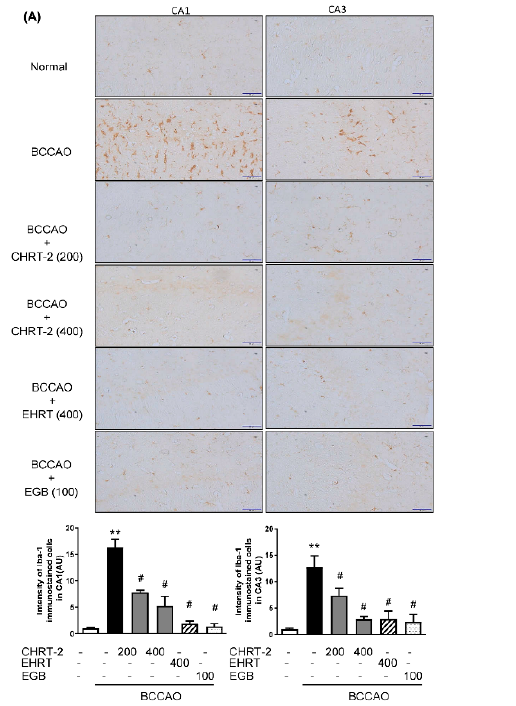
Figure 5. Effect of HRT on inflammatory responses in the BCCAO-induced VaD rats. ( A ) Immunohistological analysis was carried out to examine the expression of ionized calcium binding adaptor molecule 1 (Iba-1), a microglial marker, in the hippocampus of BCCAO rats. Representative photomicrographs are shown at magnifications of 400 × . The immunohistochemical signal intensity was calculated in a brain tissue section from each rat using Image J software. The staining intensity results are reported in arbitrary units (AU). ( B ) Hippocampal tissues were lysed and subjected to Western blotting for detecting phosphorylated mitogen-activated protein kinases (MAPKs) including extracellular signal-regulated kinase (ERK), c-Jun N-terminal kinase (JNK), and p38 MAPK. Expression levels were normalized to the expression of actin. Data are presented as means ± SEM ( n = 8); ** p < 0.01 vs. normal group, # p < 0.05 and ## p < 0.01 vs. BCCAO group.